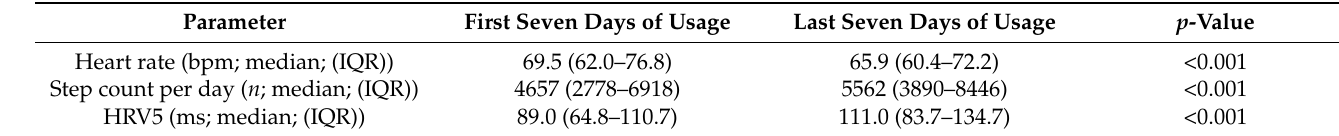
Table 2. Median heart rate, step count per day, and HRV5 between the first and last seven days of usage. Parameter